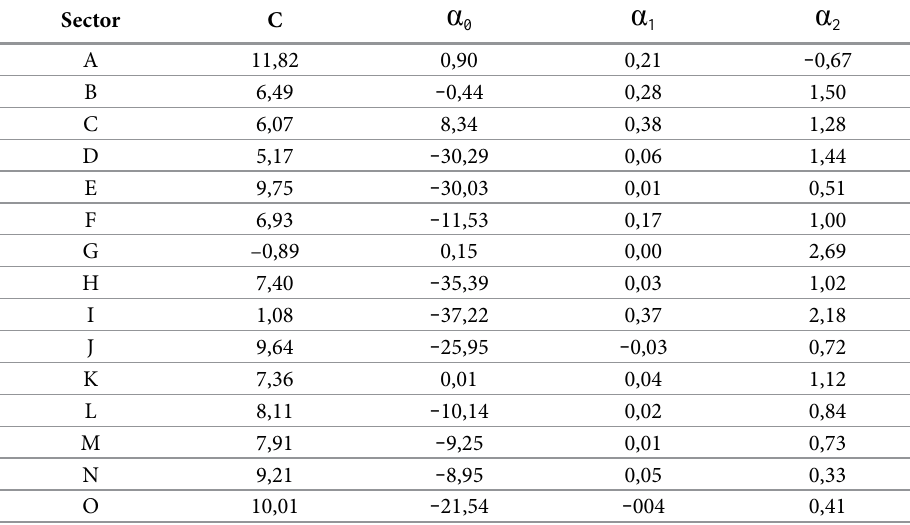
table 1. Coefficients of the labour force logarithmical